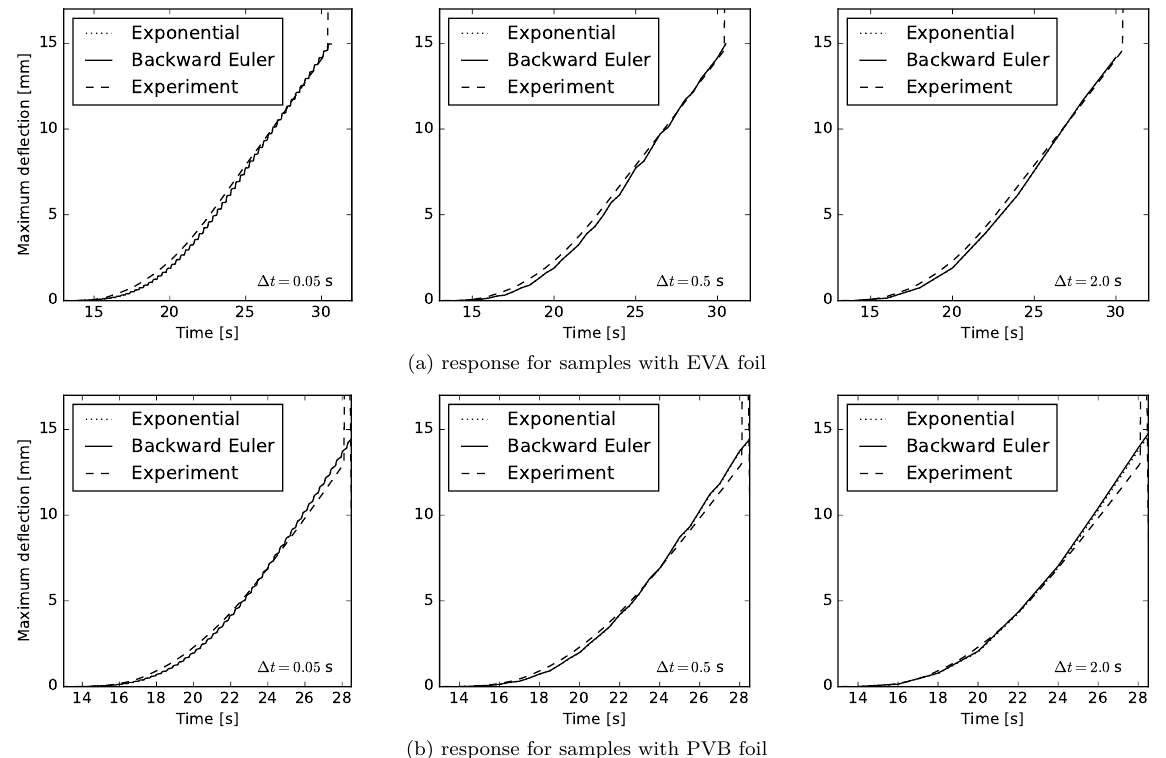
Figure 6. Validation of numerical responses provided by the Exponential and Backward Euler method against the experimental measurement for three different time steps: ∆ t = 0 . 05 s, ∆ t = 0 . 5 s and ∆ t = 2 . 0